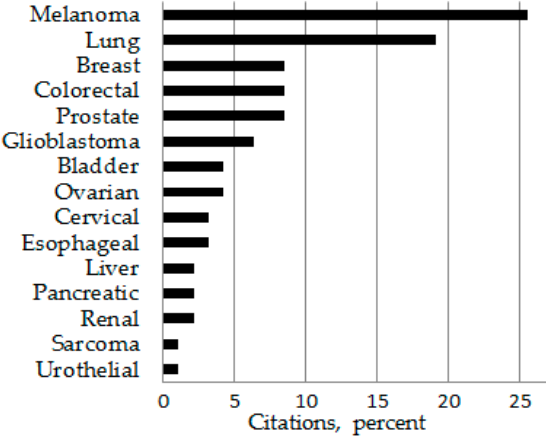
Figure 1. Cancer immunotherapy citations in PubMed.